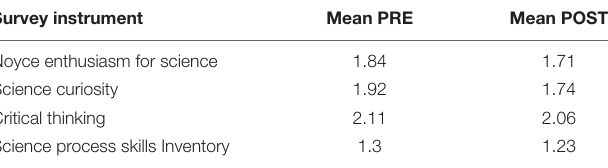
TABLE 2 | Mean survey instrument responses for participants pre and post